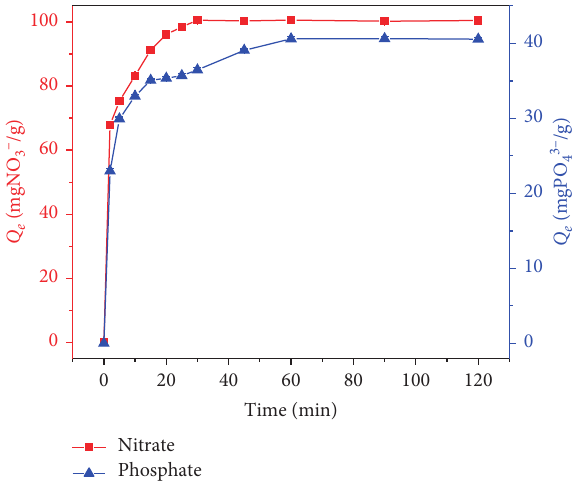
Figure 6: Effects of the contact time on nitrate and phosphate adsorption of ferric oxide-amine